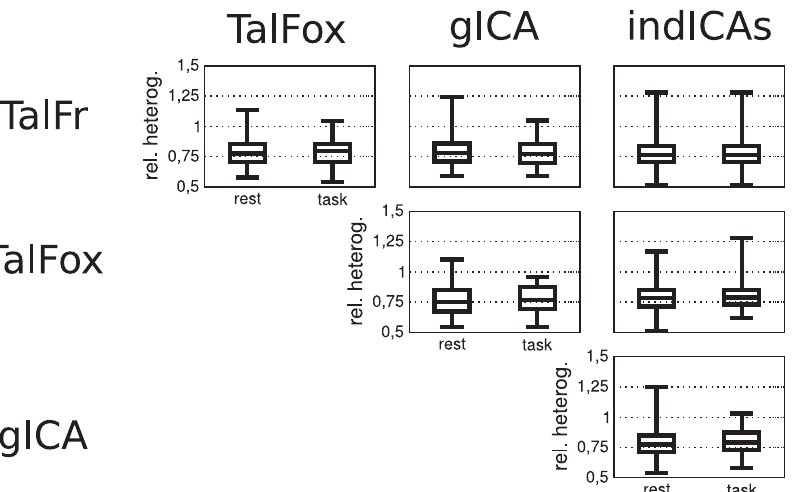
Figure 5. Relative spatial functional heterogeneity as a function of pair of methods and condition. The bottom and top of the box are the 25th and 75th percentile (the lower and upper quartiles, respectively), and the band in the box is the 50th percentile (median); whiskers represent minimum and maximum values.